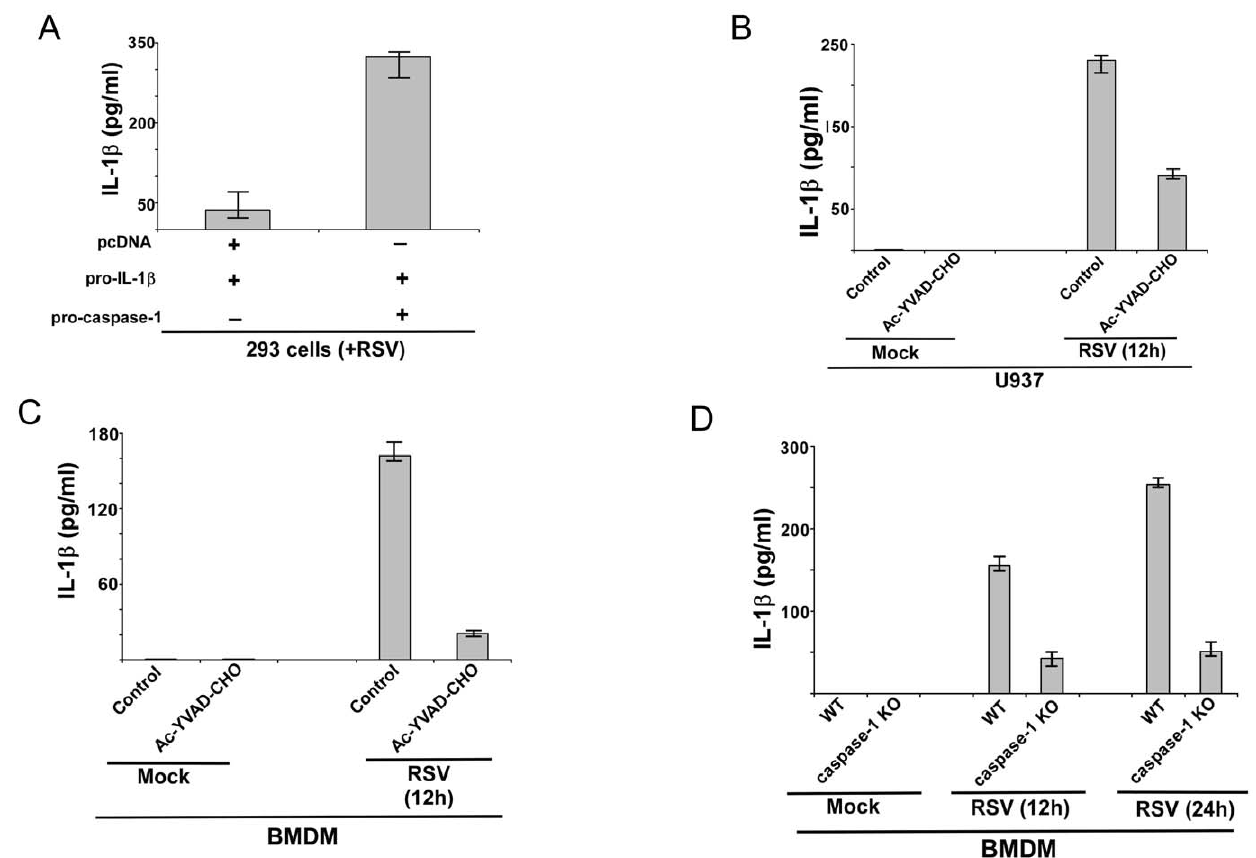
Figure 1. Caspase-1 dependent IL-1 b release during RSV infection. ( A ) 293 cells were transfected either with pcDNA (control), pro-IL-1 b and/ or pro-caspase-1 plasmids. At 24 h post-transfection, cells were infected with RSV (1 MOI). At 12 h post-infection, medium supernatant was assessed for IL-1 b protein by ELISA analysis. ( B ) Human macrophagic U937 cells were infected with RSV (1 MOI) in the presence of either water (vehicle control) or caspase-1 inhibitor (10 m M of Ac-YVAD-CHO). IL-1 b levels in the medium supernatant were assayed by ELISA at 12 h post-infection. ( C ) Primary mouse bone marrow derived macrophages (BMDM) were infected with RSV (1 MOI) in the presence of either water (vehicle control) or caspase-1 inhibitor (10 m M of Ac-YVAD-CHO). IL-1 b levels in the medium supernatant were assayed by ELISA at 12 h post-infection. ( D ) Wild type (WT) or caspase-1 knock-out (KO) BMDMs were infected with RSV (1 MOI). IL-1 b levels in the medium supernatant were assayed by ELISA at 12 h and 24 h post-infection. Each value represents the mean 6 standard deviation from three independent